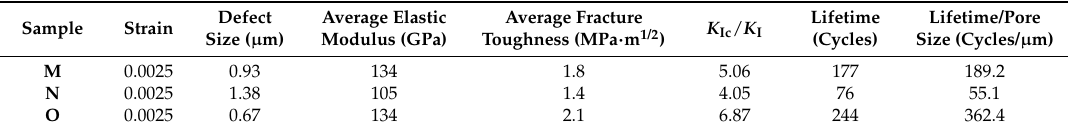
Table 4. Input parameters and evaluation according to Equation (7) for the SPS coatings.